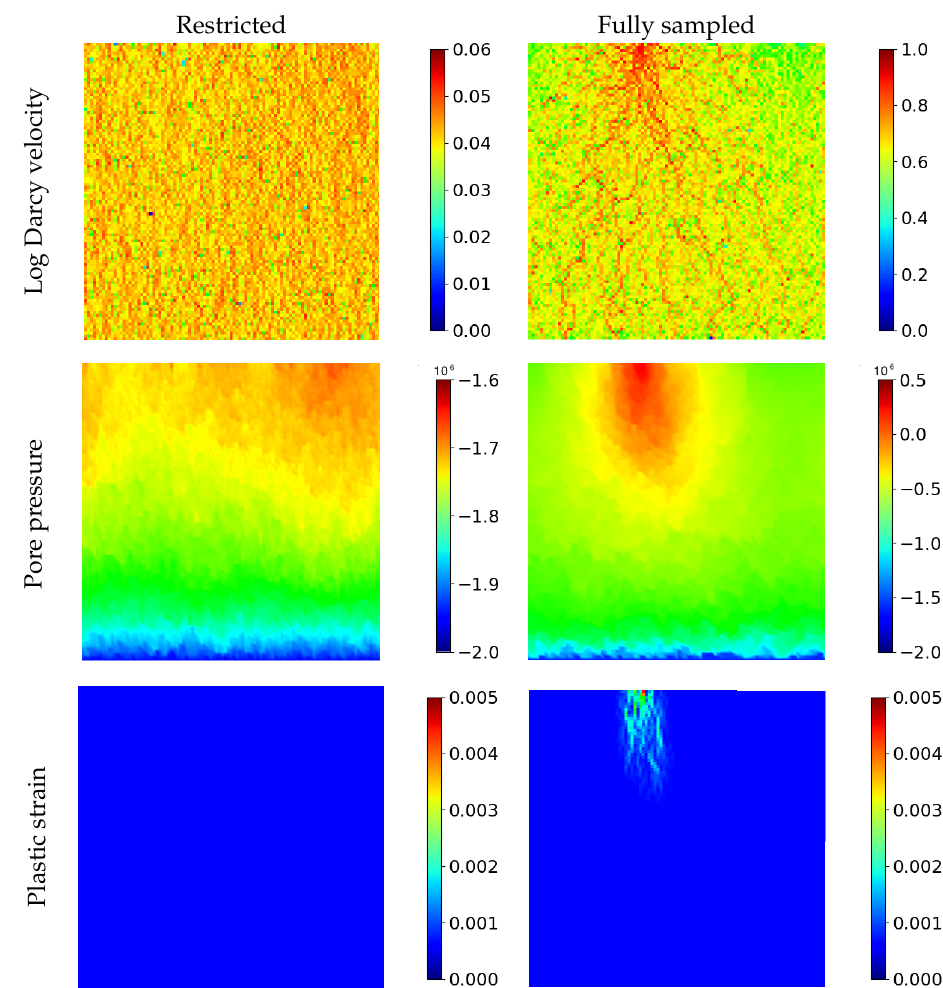
Figure 6. Results of the two simulations showing the log-magnitude of Darcy velocity, pore-water pressure and resultant plastic strain with restricted and fully sampled